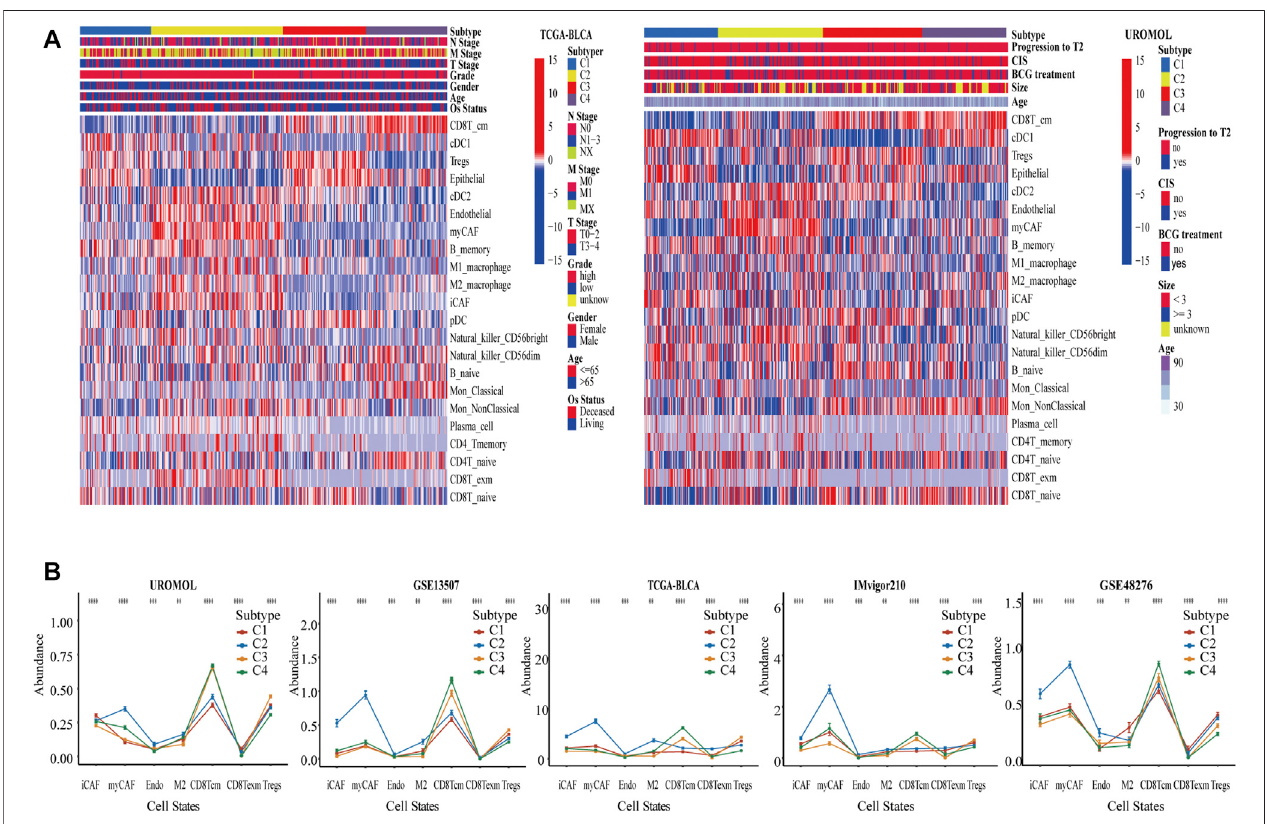
FIGURE2| Identi fi cationofBCsubtypesbyclusteringcellstates. (A) Basedon22cellstatesinBC,UROMOL,GSE13507,andGSE48276cohortswereclustered intofoursubtypes,andwasvalidatedbyTCGA-BLCAcohortetal.WeonlyshowtwoheatmapsofUROMOLandTCGA-BLCAcohorts. (B) Thelinegraphdemonstrates signi fi cant level of cell states among four subtypes in multiple cohorts. * p < .05, ** p < .01, and *** p < .001. Abundance means the absolute proportion of cell states.